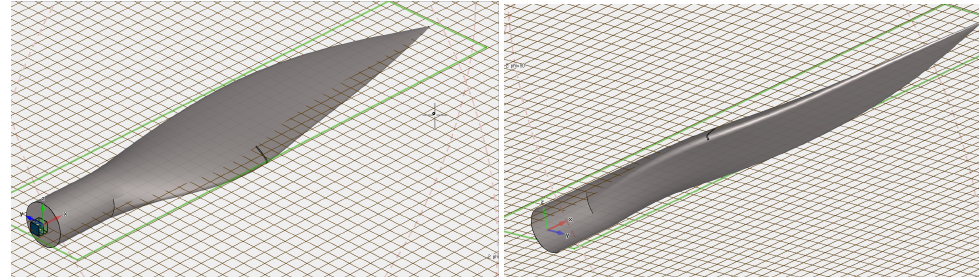
Figure 26. Rotor blade of a turbine with a crack.